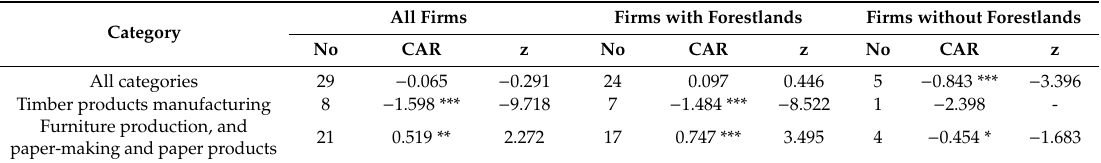
Table 5. Results of testing policy IV.